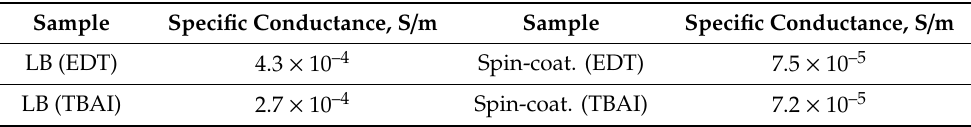
Table 1. The calculated specific conductance obtained for the LB and spin-coated samples.